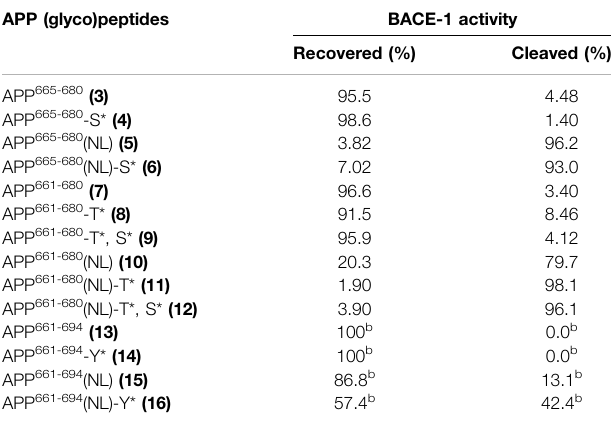
TABLE 3 | Proteolytic cleavage of APP (glyco)peptides 3 – 12 upon treatment with BACE-1 enzyme (KM~D/NL~D cleavage site) a . APP